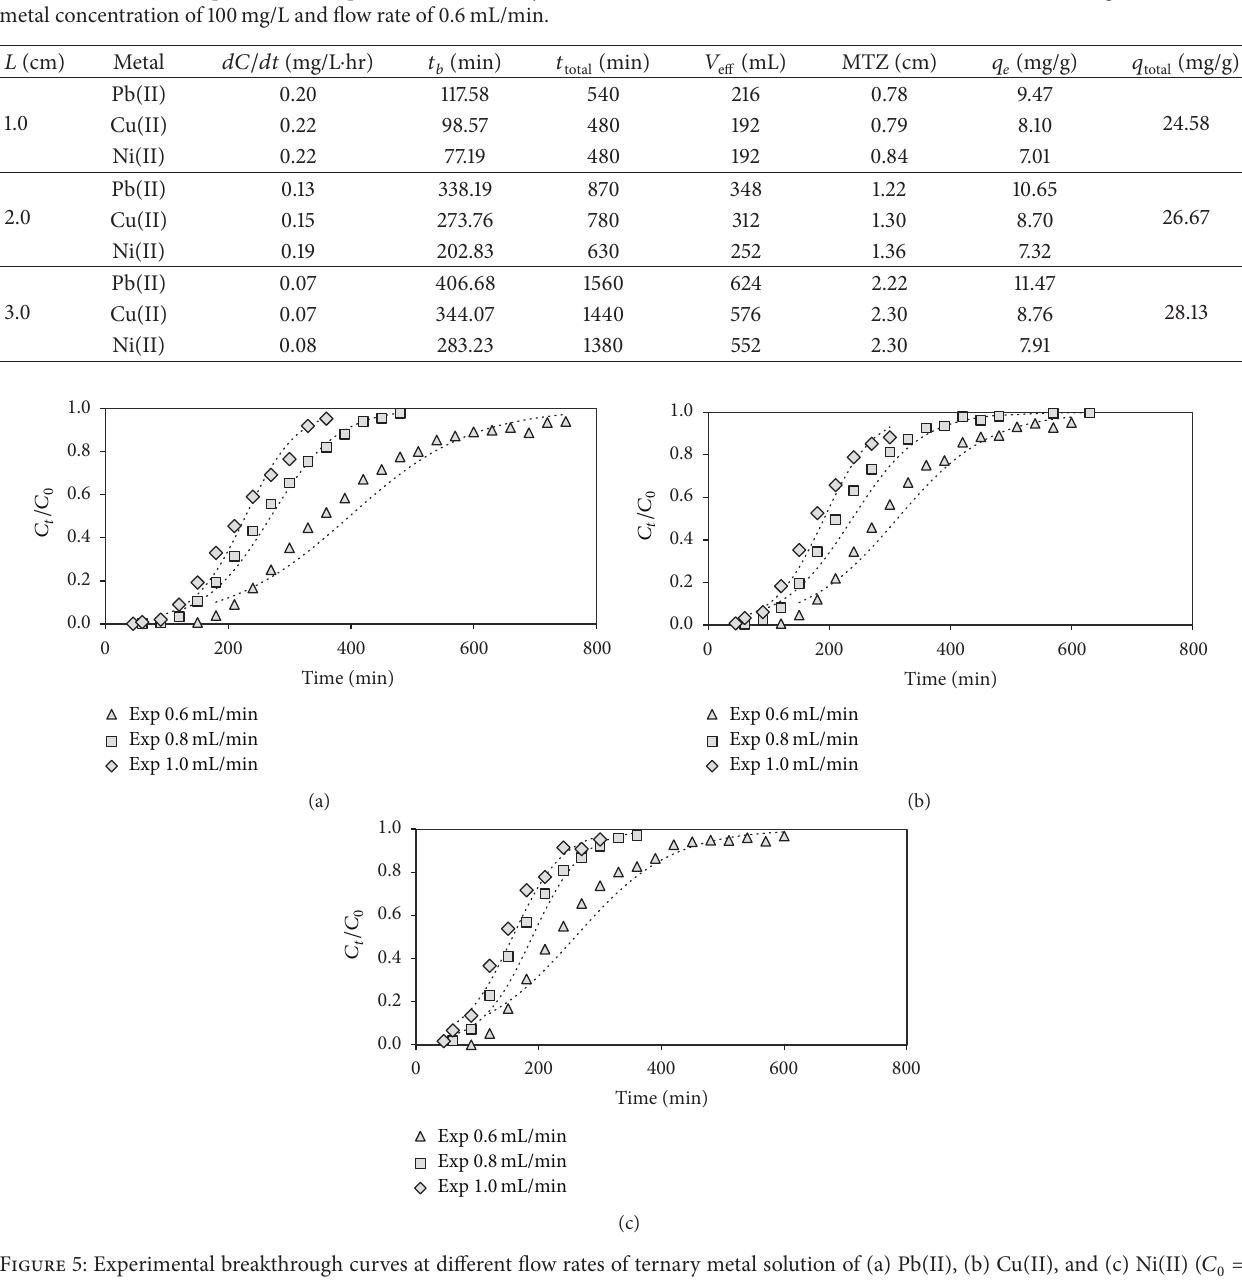
Figure 5: Experimental breakthrough curves at different flow rates of ternary metal solution of (a) Pb(II), (b) Cu(II), and (c) Ni(II) ( 𝐶 0 = 100mg/L; 𝑄 = 0.4 mL/min; model fit is shown as ⋅⋅⋅